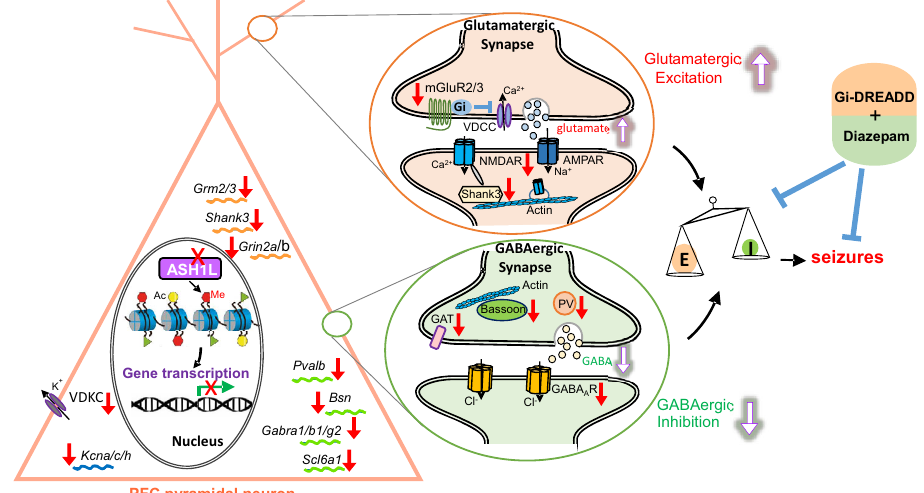
Fig. 7 A schematic model showing the causal relationship between Ash1L de fi ciency and altered synaptic gene expression and neuronal excitability. Knockdown of Ash1L , a histone methyltransferase catalyzing the permissive H3K4me3, causes the reduced H3K4me3 at synaptic gene promoters, leading to the reduced transcription of excitatory synaptic genes (e.g., Grm2/3, Grin2a/b, Shank3 ) and inhibitory synaptic genes (e.g., Bsn , Pvalb , Gabra1/b1/g2, Scl6a1 ). Consequently, glutamatergic transmission is elevated, which is likely due to the loss of Gi-coupled mGluR2/3-mediated inhibition of voltage- dependent calcium channels (VDCC) and glutamate release 70 , while GABAergic transmission is diminished, which is likely attributable to the loss of GABAergic synapses or postsynaptic GABA A Rs. The E/I balance is switched to more excitation, which induces severe seizures and early mortality. Treatment with the Gi-DREADD and GABA A R positive allosteric modulator diazepam can ameliorate E/I imbalance and limit protease inhibitor) and incubated on ice for 30 min with periodic vortexing to resuspend the pellet. After centrifugation, the supernatant for nuclear fractions was collected, boiled in 2 × SDS loading buffer for 5min, and then separated on 6 or 12% SDS-polyacrylamide gels. Western blotting experiments for nuclear proteins were performed with antibodies against Ash1L (1:1000, LSBio, LS-B11718), H3K4me3 (1:1000, Cell Signaling, 9751), H3K36me2 (1:1000, Cell Signaling, 2901), H3K36me3 (1:1000, Cell Signaling, 9763), and Histone 3 (1:500, Cell Signaling, 4499).